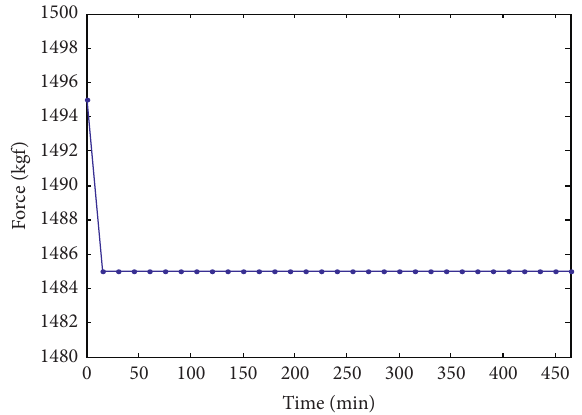
Figure 4: Result of the tensile pressure holding test.